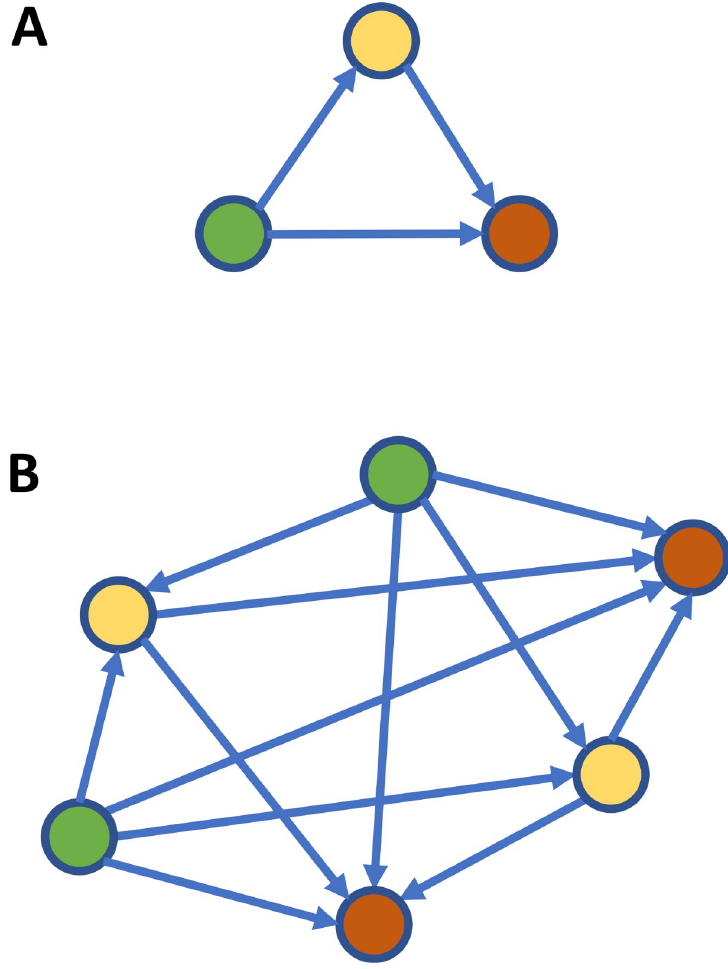
Fig 7. Simple network motif (feed forward loop) before (A) and after (B) genome wide duplication. After duplication, network complexity has increased and random mutations may affect (many) more genes, in turn increasing the chance of causing major disturbances to the GRN and underlying